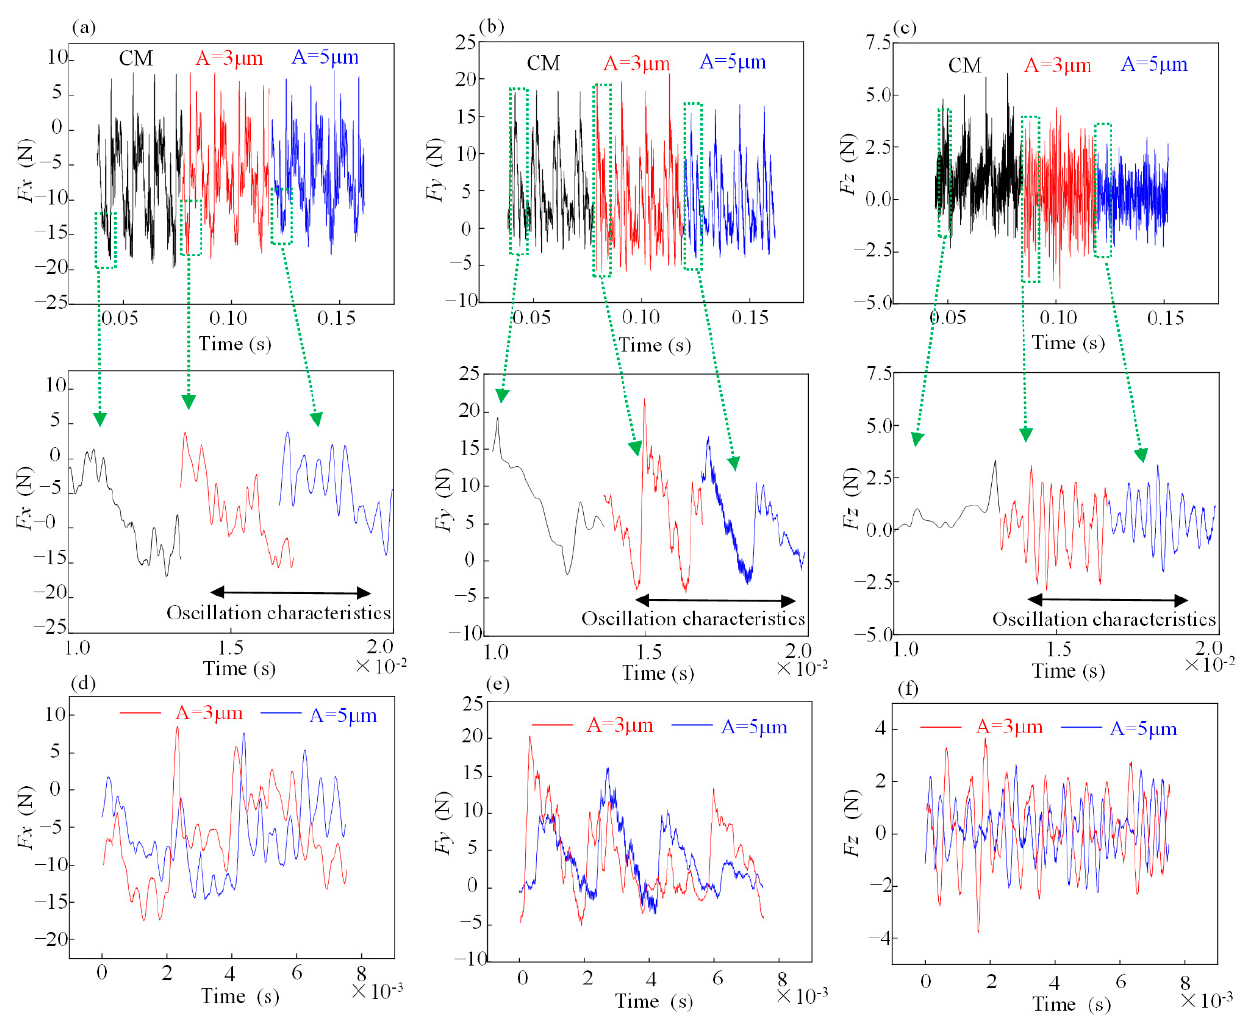
Figure 8. Single-factor test on the milling force signal ( n s = 8000 r/min, f z = 10 µ m, a p = 0.5 mm). ( a – c ) The collected milling force signals Fx , Fy and Fz ; ( d – f ) Milling force signals of Fx , Fy and Fz at amplitudes A = 3 µ m and A = 5 µ m during one cycle of tool tip contact with the work- piece.